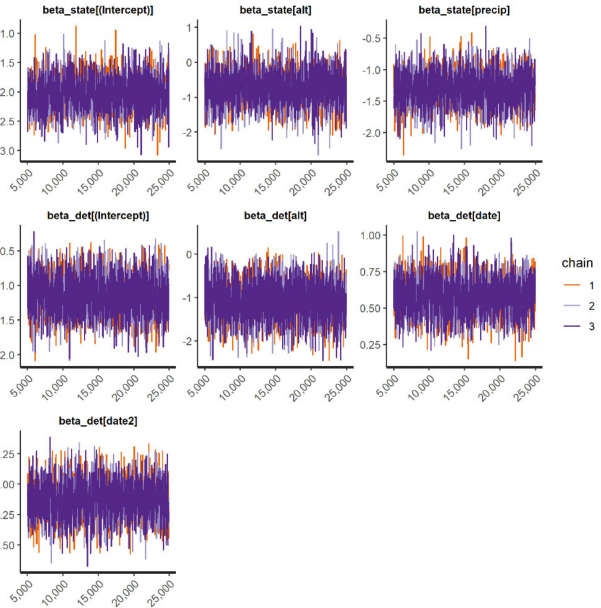
Figure A7. Traceplots from the best spatial occupancy model of Venezuelan troupial